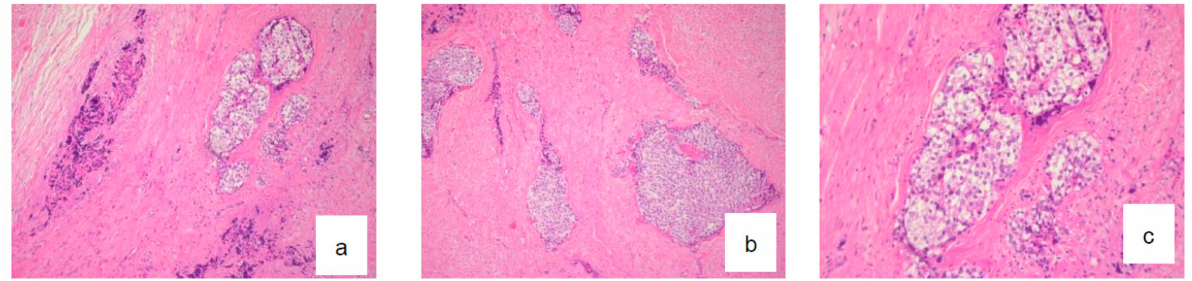
Figure 2. Histological aspect of CCOC on hematoxylin-eosin stain ( a ) × 4, ( b ) × 10, and ( c ) × 20.